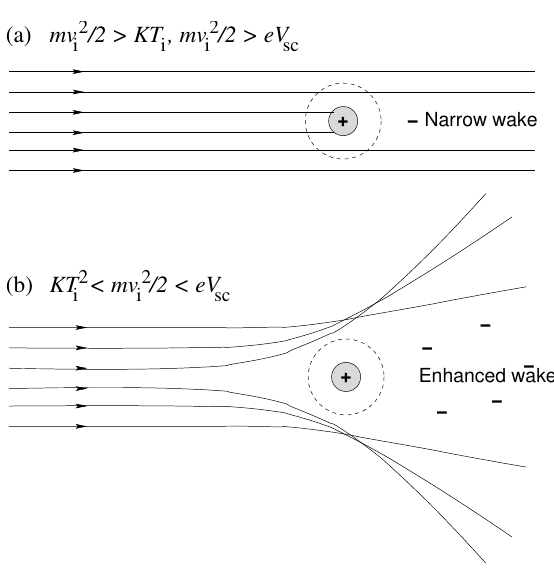
Fig. 12. Diagram illustrating ion wake formation behind a positive Fig. 12. Cartoon illustrating ion wake formation behind a positive body subject to a supersonic ion flow from the left. The centre body body subject to a supersonic ion (cid:3)ow from the left. The centre body could be the spacecraft itself, or a cut at right angles through a wire could be spacecraft itself, or a cut at right angles through a wire boom. (a) When the ion drift speed is higher than the spacecraft boom. (a) When the ion drift speed is higher than the spacecraft potential, the wake width is determined by the spacecraft geometric potential, the wake width is determined by the spacecraft geometric size. (b) When the potential is much higher than the ion flow en- size. (b) When the potential is much higher than the ion (cid:3)ow en- ergy, the ions deflect off the potential, so a measure of the effective ergy, the ions de(cid:3)ect off the potential, so a measure of the effective obstacle size is set by the equipotential surface corresponding to the obstacle size is set by the equipotential surface corresponding to the ion flow energy (dashed). The wake transverse size may thus be ion (cid:3)ow energy (dashed). The wake transverse size may thus be significantly larger than the geometrical dimensions of the body. In signi(cid:2)cantly larger than the geometrical dimensions of the body. In both cases, the wake is charged negatively by the random motion of both cases, the wake is charged negatively by the random motion of the subsonic the subsonic electrons.